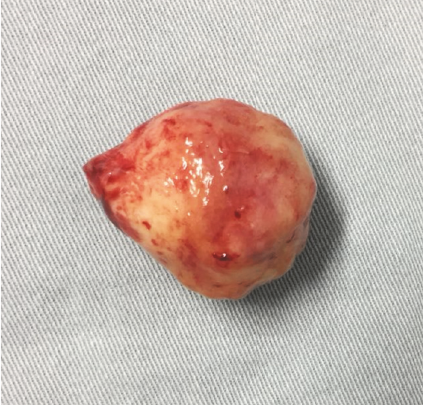
Figure 1: UTROSCT removed from the patient’s uterus.